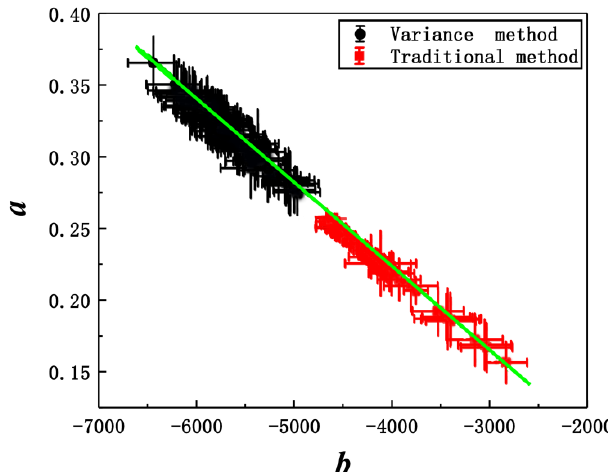
Figure 13. Distribution of the transfer coefficients of a and b for a number of data traces obtained at different scan measurements. An identical linear relationship was found for both the variance-based gluing method and the traditional method (green line).